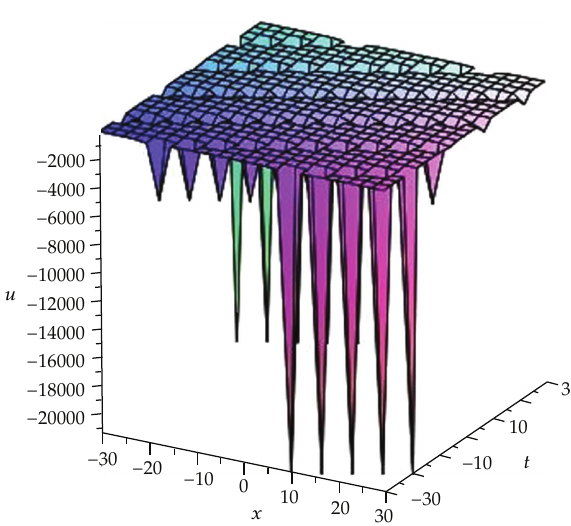
Figure 11: The solution u 15 of GSWW equation with k (cid:7) 0 . 3, c (cid:7) 2, α (cid:7) 3, β (cid:7) 1.